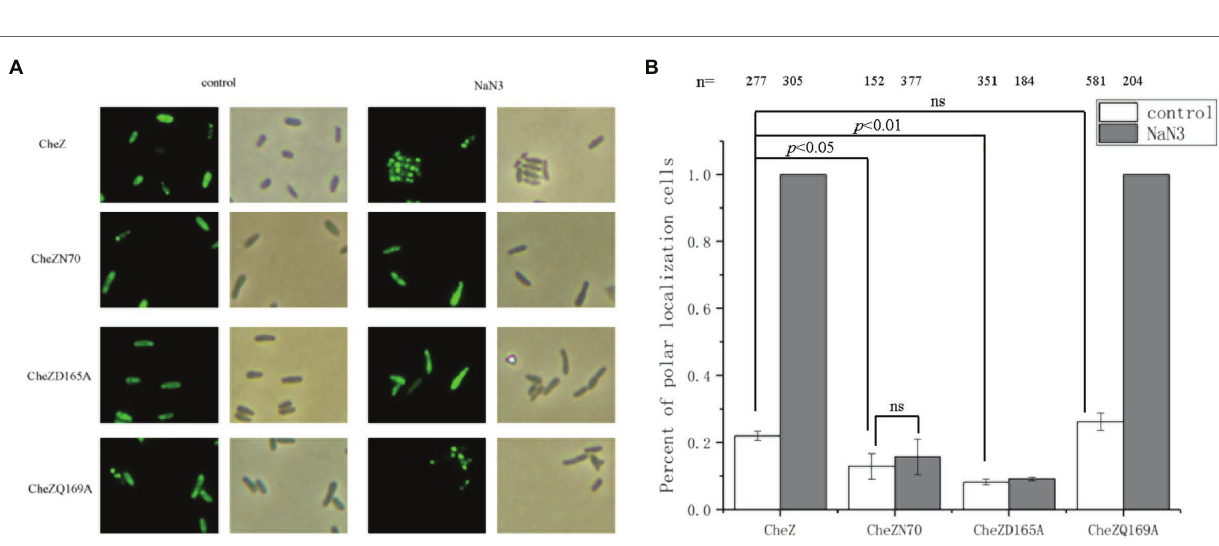
FIGURE 4 | Role of the C-terminus of CheZ and phosphatase active sites on the localization of CheZ. (A) Images of cellular localization of the CheZN70, which the 70 residues at the N-terminus of CheZ was remained, and two CheZ substitution mutants CheZD165A and CheZQ169A. (B) Quantification of cell ratios with polar localization of CheZ, CheZN70, CheZD165A or CheZQ169A. Data are means and SDs from three independent experiments. The significant difference compared with control was analyzed by one-way ANOVA with Tukey’s test ( p < 0.01 and p <